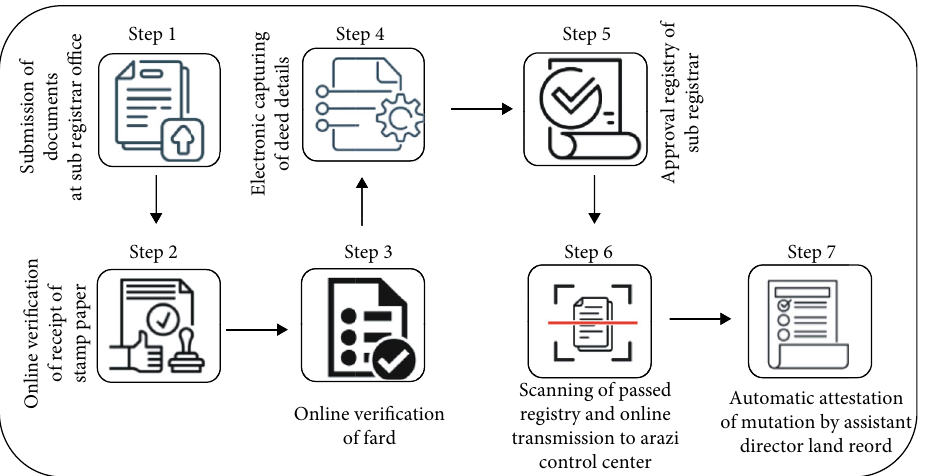
Figure 5: Registrar o ffi ce process.